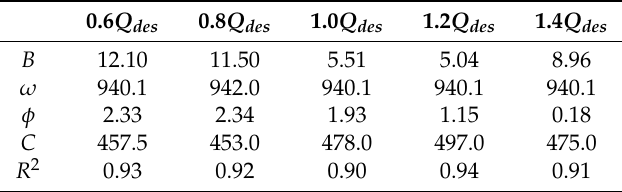
Table 4. Fitting parameters for head fluctuation in different working conditions.